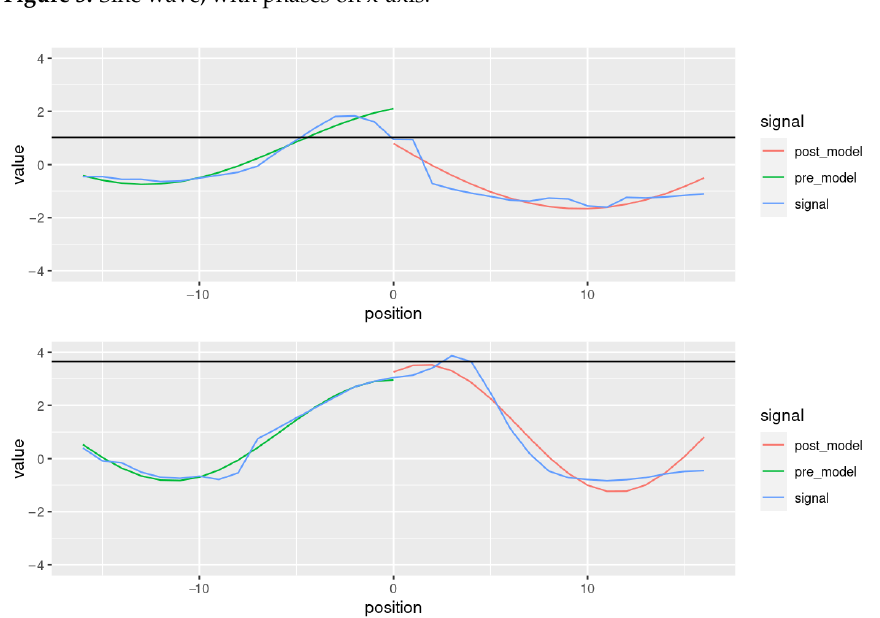
Figure 3. Sine wave, with phases on x-axis.